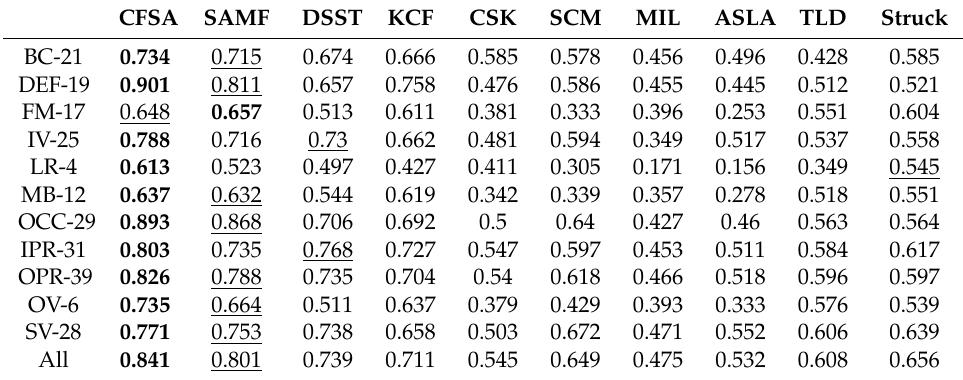
Table 1. The precision scores of CFSA tracker and nine other trackers at the center location error threshold = 20 pixels on the OOTB dataset. Bold and underline values indicate best and second performances, respectively.